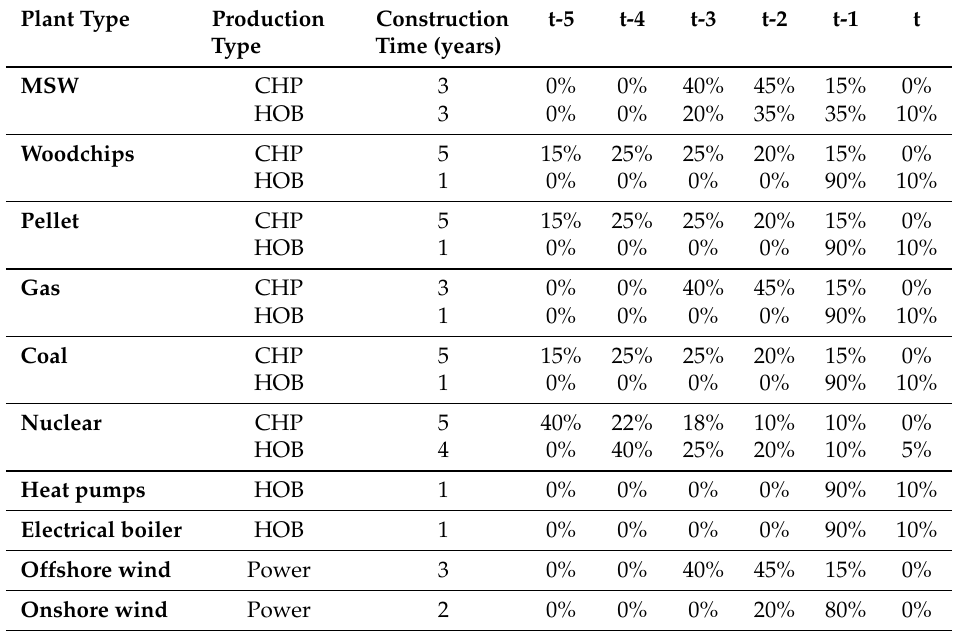
Table A1. The presumed ramp-up of the capital costs of new power plants towards their completion in year t. Plant